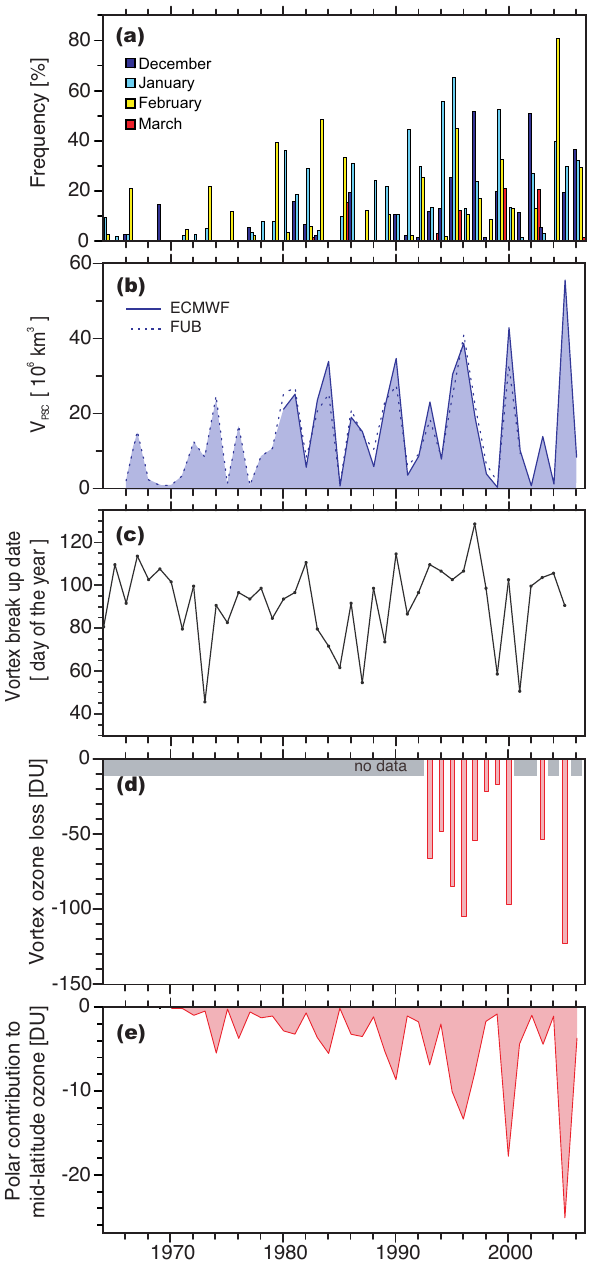
Fig. 6. The evolution of vortex properties underlying chemical ozone loss are shown in the the top three panels: (a) inferred PSC existence at 50hPa in the winter months derived from temperature measurements made by radiosondes at Sodankyl¨a, Finland; (b) in- ferred volume of PSCs derived from ECMWF (solid) for 1979– 2006 and FU Berlin (dashed) for 1966–2001 as in Rex et al. (2004); and (c) vortex break-up dates (updated from Karpetchko et al., 2005). The interannual variation of ozone loss is shown in the lower two panels: (d) the chemical ozone loss in the vortex estimated from observations of ozone using the vortex average approach (Rex et al., 2004); and (e) the estimated impact on mid-latitude ozone columns in May using the approach of Wohltmann et al.